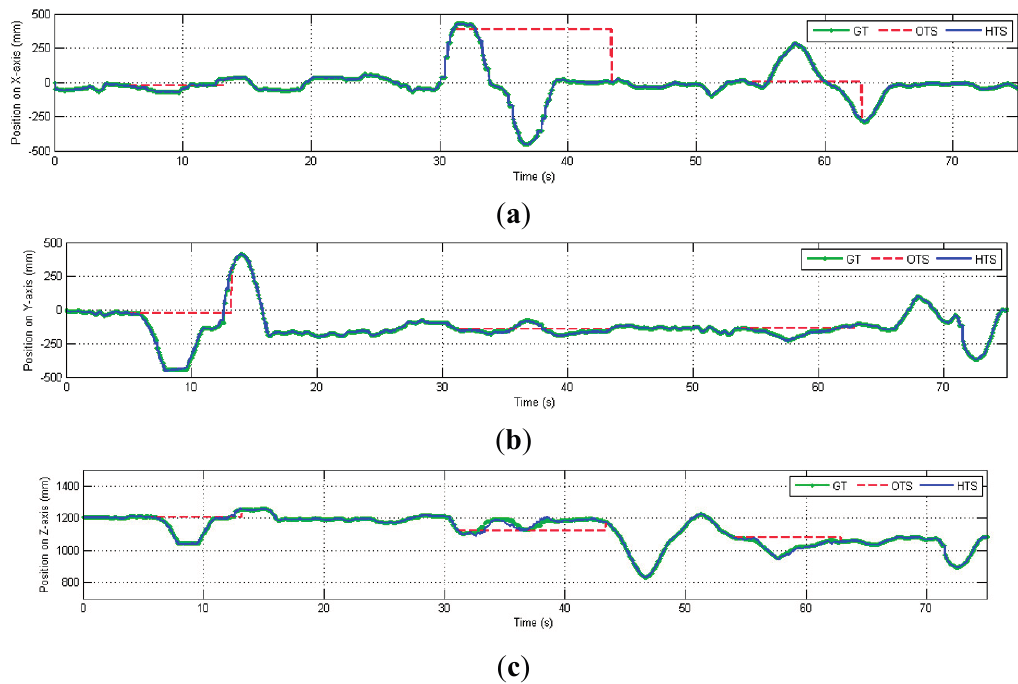
Figure 12. Position (mm) in three-axes versus time, including cases of partial OTS occlusion (dashed red lines). ( a ) Position on X-axis; ( b ) Position on Y-axis; ( c ) Position on Z-axis.